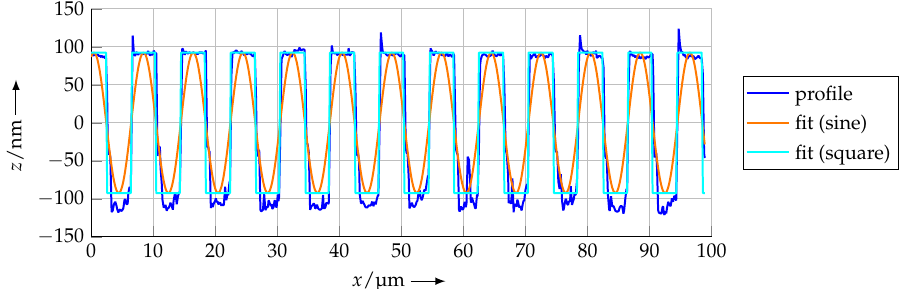
Figure 13. Best fit sine function and square function, tuned to the measured profile by minimising the squared